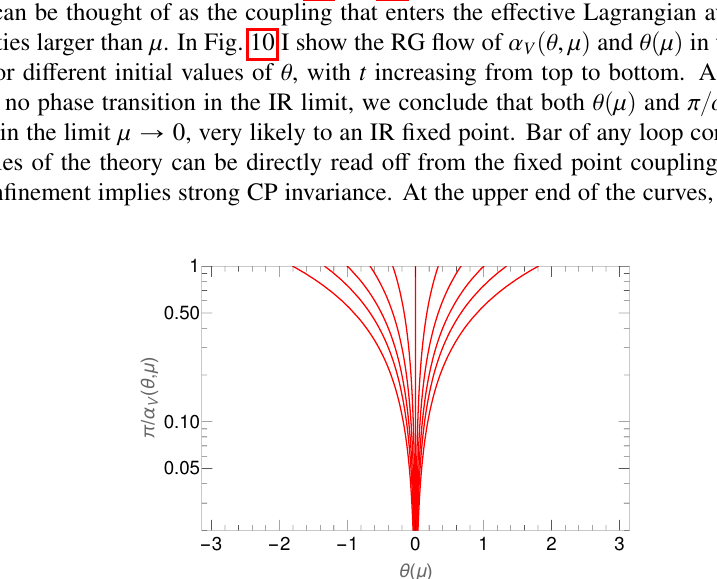
Figure 10. The RG flow of α V p θ,µ q and θ p µ q in the p θ,π { α V q plane for di ff erent initial values of θ , with t increasing from top to